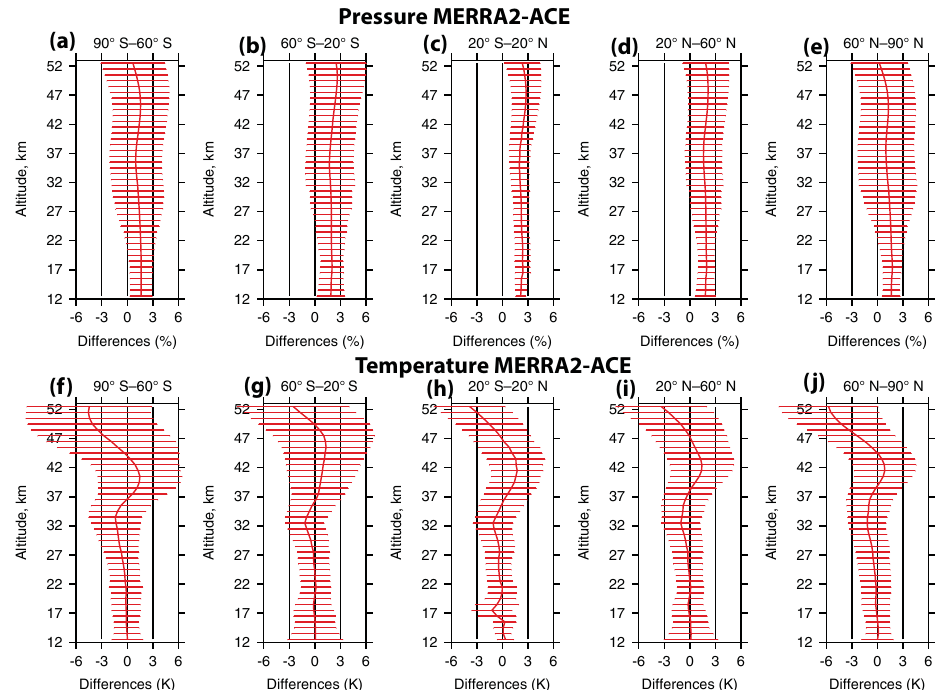
Figure 17. Mean differences between MERRA-2 and ACE-FTS pressure (a–e) and temperature (f–j) profiles in five wide latitude bins. Biases for pressure are expressed in percent, while temperature biases are shown in degrees (K). Horizontal error bars show 1 σ standard deviations of the corresponding